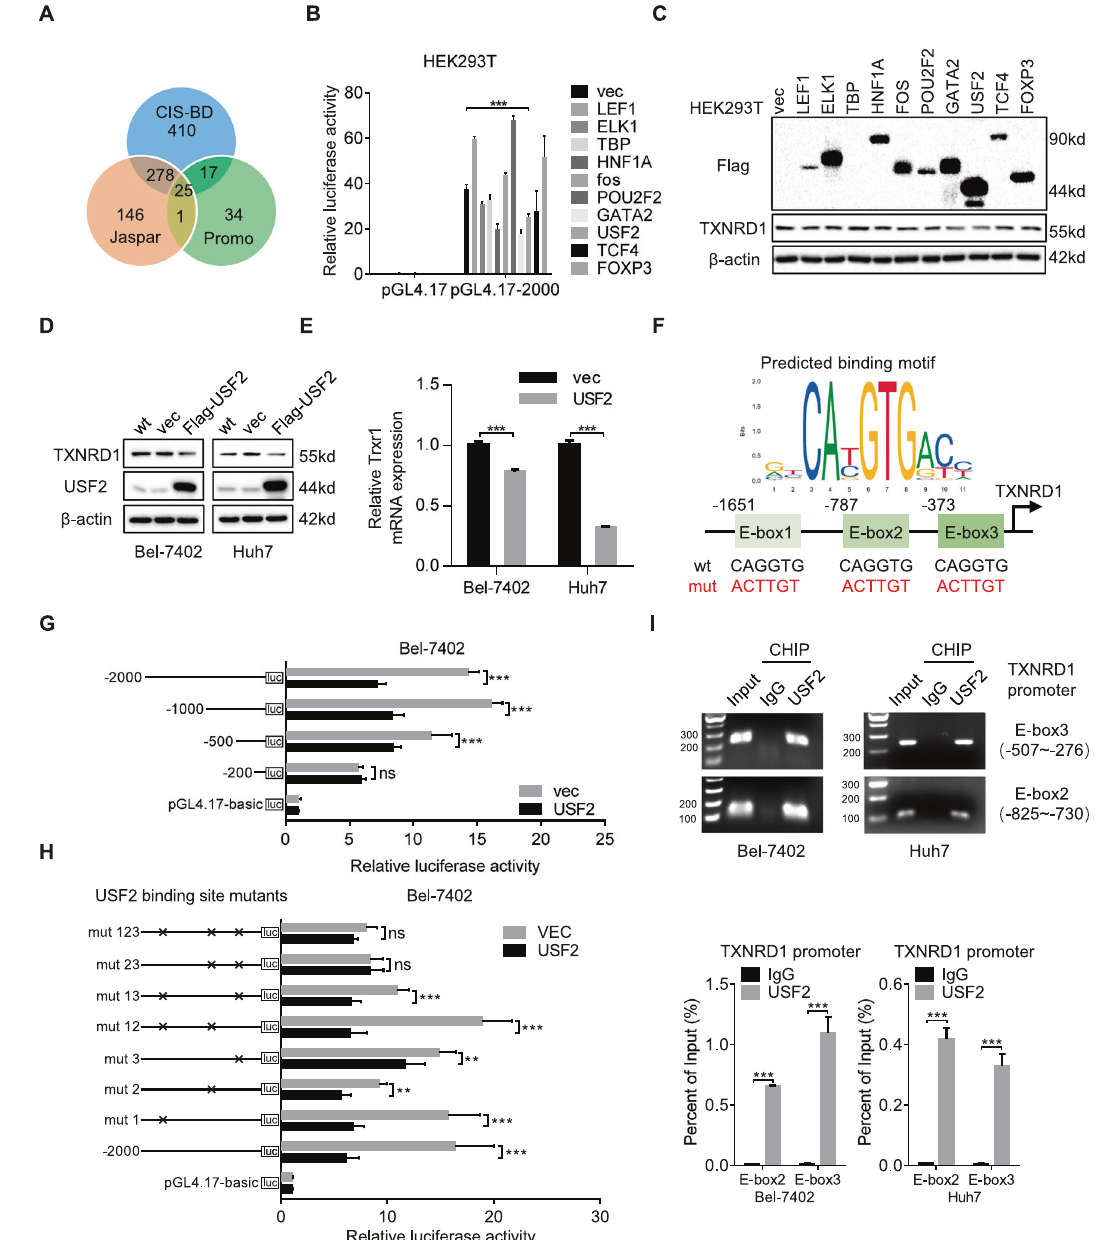
Fig. 5 TXNRD1 is regulated by USF2 through the transcriptional suppression. A Venn diagrams show overlaps of putative transcription factors which might bind to the TXNRD1 promoter from three different database. B Relative luciferase activity was detected to analyze the regulation of ten transcription factor in the 2-kilobase human TXNRD1 promoter in HEK293T cells. C HEK293T cells were transiently transfected with ten transcription factors with Flag tag or empty vector for 24 h. Western blot was carried out to con fi rm the overexpression of indicated transcription factors and detect the protein level of TXNRD1. D Western blot analysis of TXNRD1 and USF2 following transient transfection of Flag-USF2 or vector control in Bel-7402 and Huh7 cells. E The mRNA levels of TXNRD1 were detected by qRT-PCR in Bel-7402 and Huh7 cells transiently transfected with Flag-USF2 or vector control. F Sequences of the canonical USF2-binding E-box motif, putative USF2-binding E-box sites in TXNRD1 promoter, and introduced point mutations used to inactivate the E-box site. G Fragments of the TXNRD1 promoter are shown. Relative luciferase activities of pGL4.17 containing TXNRD1 promoter truncations in Bel-7402 cells exposed to USF2 or control vector were measured by dual-luciferase assays. H Schematic E-box mutations of the TXNRD1 promoter are shown. Relative luciferase activities of pGL4.17 containing E-box site mutations in Bel-7402 cells exposed to USF2 or control vector were measured by dual-luciferase assays. I ChIP analysis of indicated cells immunoprecipitated by anti-USF2 antibody or IgG followed by qRT-PCR using speci fi c primers targeting the USF2-bingding E-box sites in TXNRD1 promoter. Enrichment represent the percentage of input. Data represent the mean ± SEM. ns, not signi fi cant; ** P < 0.01, *** P < 0.001. P values were calculated by Student ’ s t test.